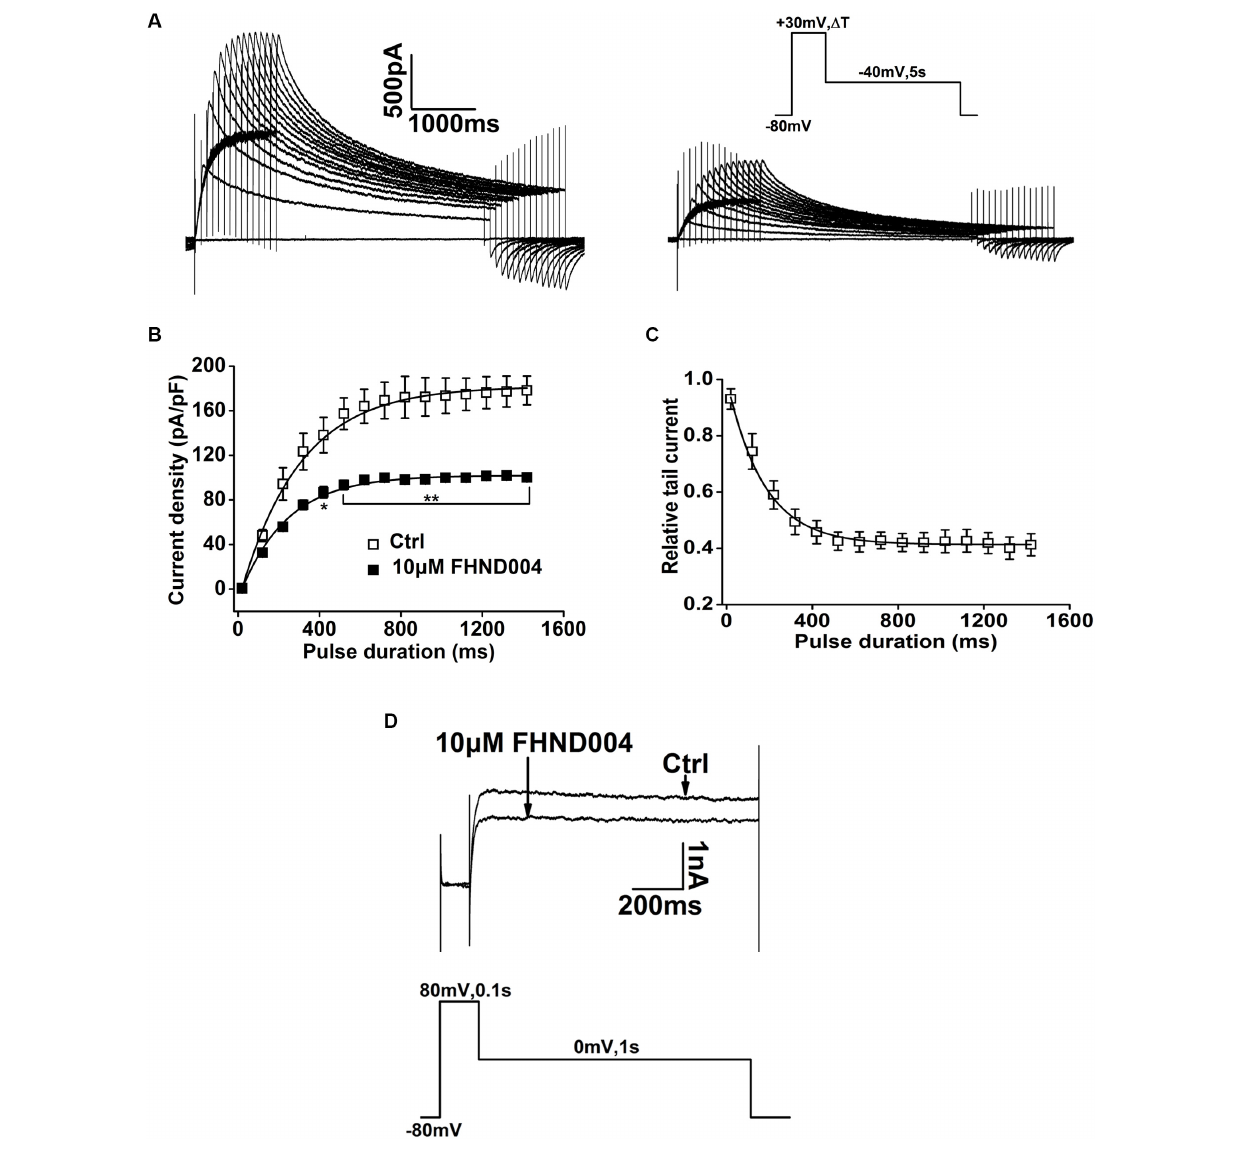
FIGURE 3 | Open channel block of hERG by FHND004. (A) Representative current elicited by the “envelope of tails” protocol before and after application of 10 µ M FHND004. Cells were held at a holding potential of − 80 mV and pulsed to depolarizing voltage ( + 30 mV) for variable durations from 20 to 1420 ms in 100 ms increments. Envelope tail currents were recorded upon repolarization to − 40 mV. (B) Mean plots of current density against development of depolarizing time fitted with single exponential equation before and after the application of 10 µ M FHND004 ( n = 6). (C) A plot of the onset of current block expressed as relative tail current [relative tail current = (currents with drug/currents without drug) × 100%]. The time-dependent decay in relative tail current was fitted to a mono-exponential equation ( n = 6). (D) Representative current traces recorded before and after the addition of 10 µ M FHND004, using the protocol shown in the inset ( n = 5).